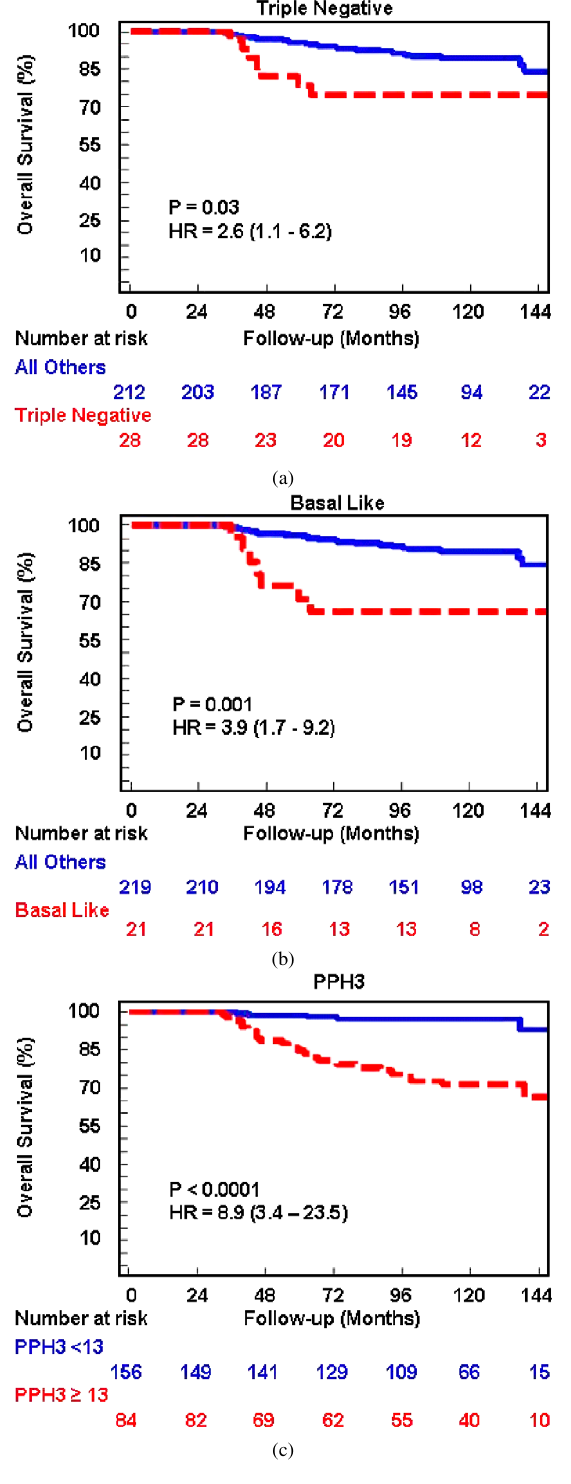
Fig. 3. Survival curves of patients stratified by (a) Triple negative phenotype, (b) Basal-like cancer phenotype and (c)